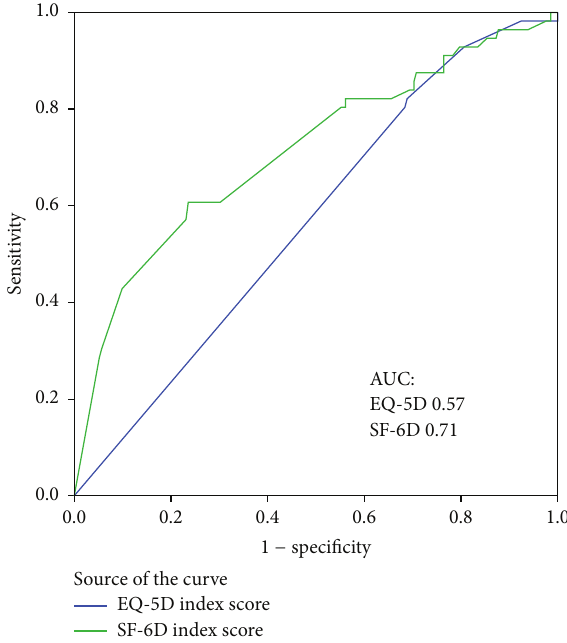
Figure 2: Receiver operating characteristic (ROC) curves of SF- 6D and EQ-5D. AUC: area under the ROC curves of SF-6D and EQ-5D index scores that depend on self-perceived general health. The discriminative ability of SF-6D and EQ-5D between patients in excellent health and patients in very good